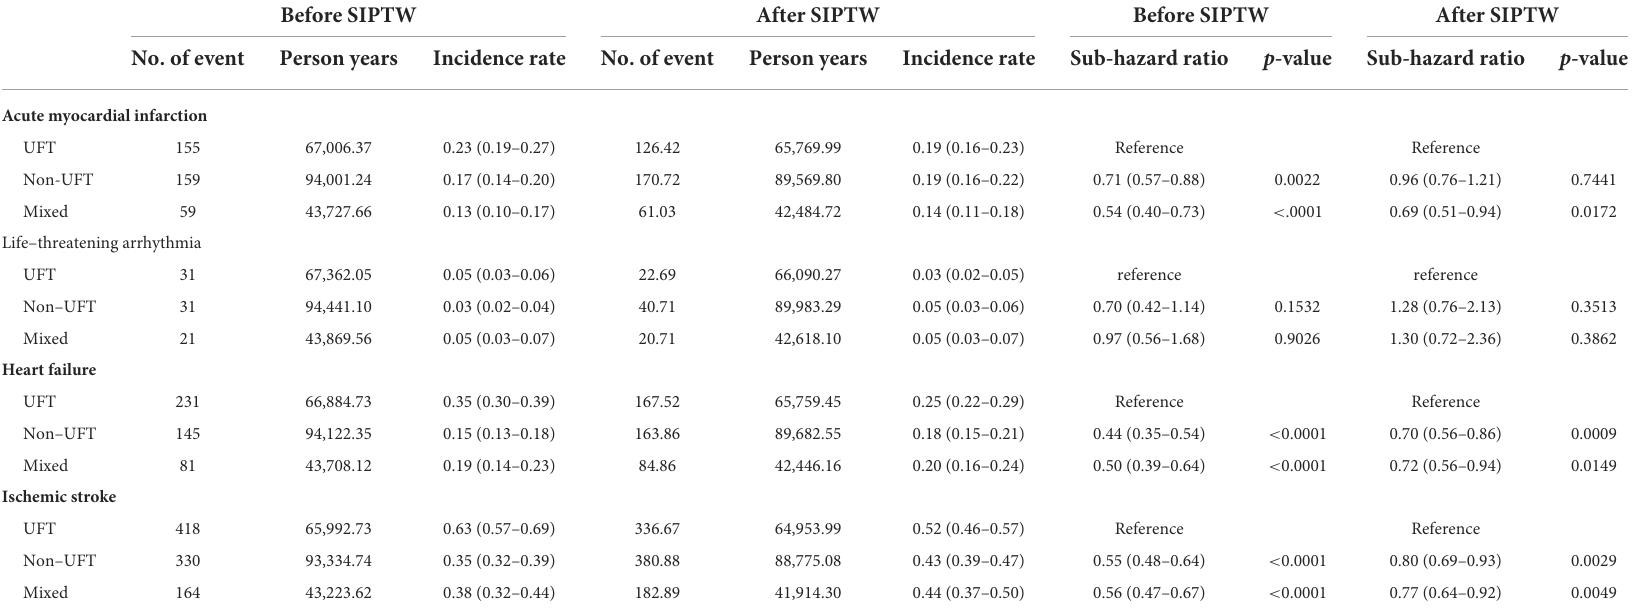
TABLE 4 Cardiovascular outcomes among patients with stage II–III colorectal cancer before and after SIPTW. Before SIPTW After SIPTW Before SIPTW After